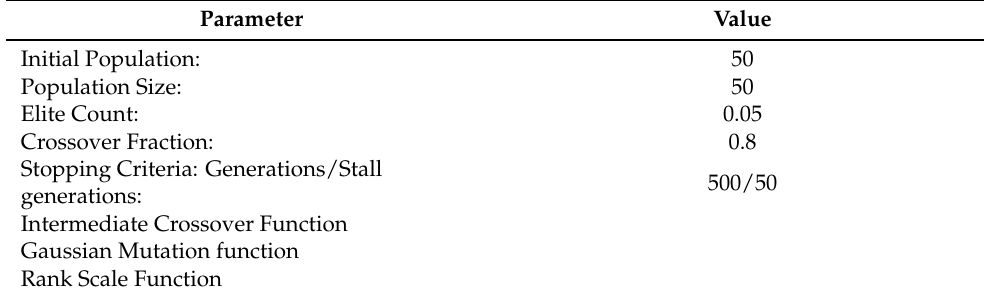
Table 2. Genetic Algorithm